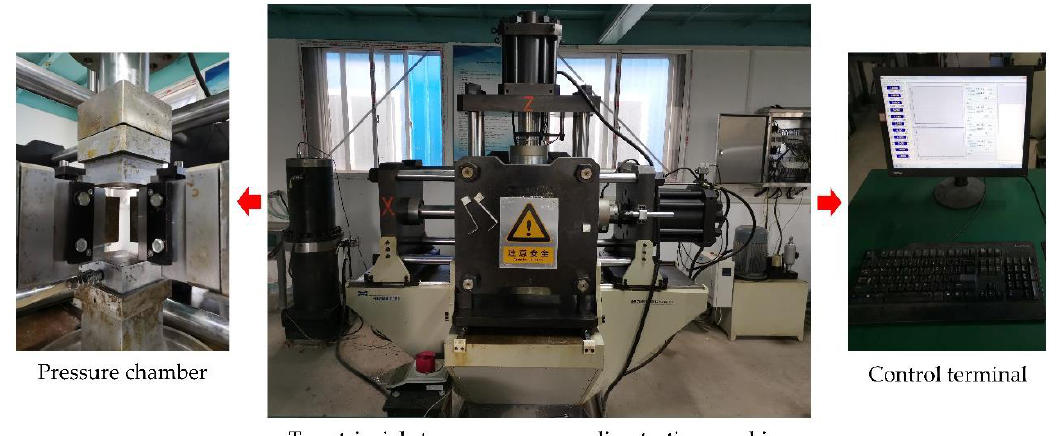
Figure 4. True triaxial seepage test system.